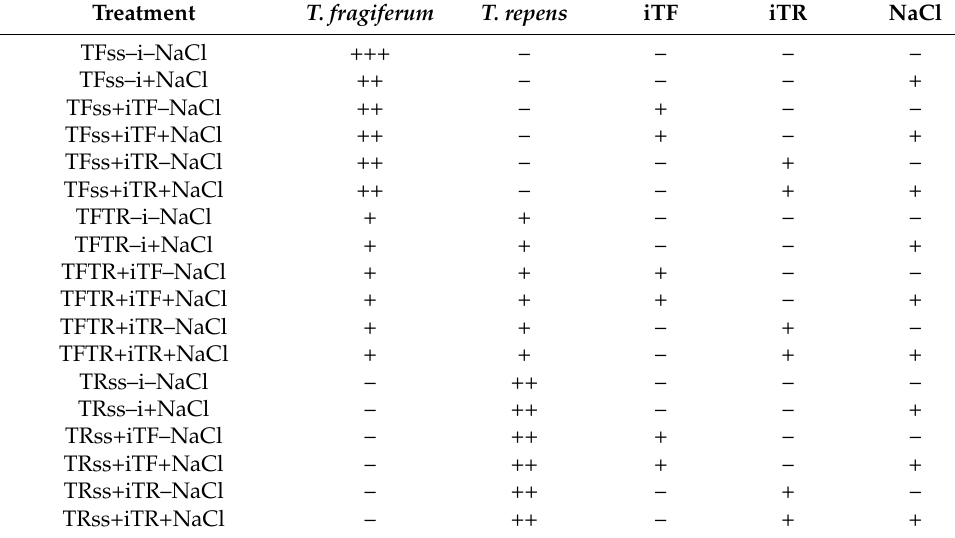
Table 1. Experimental treatments used in the present study. Treatment T.